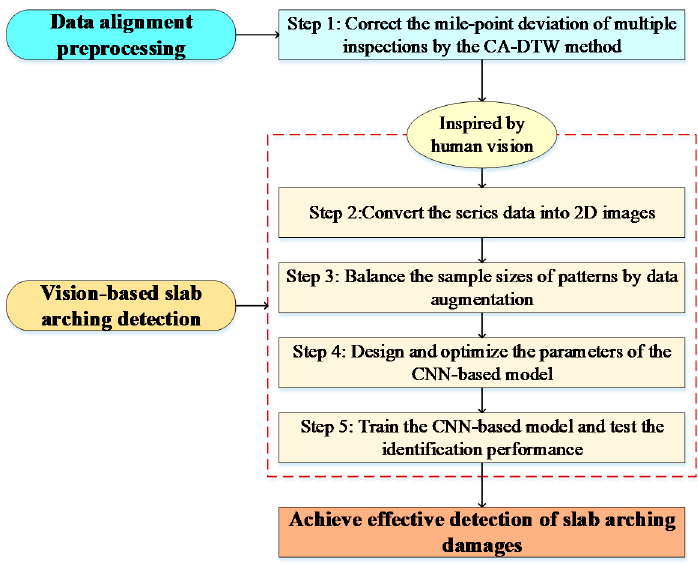
Figure 7. Flow chart of slab arching detection.